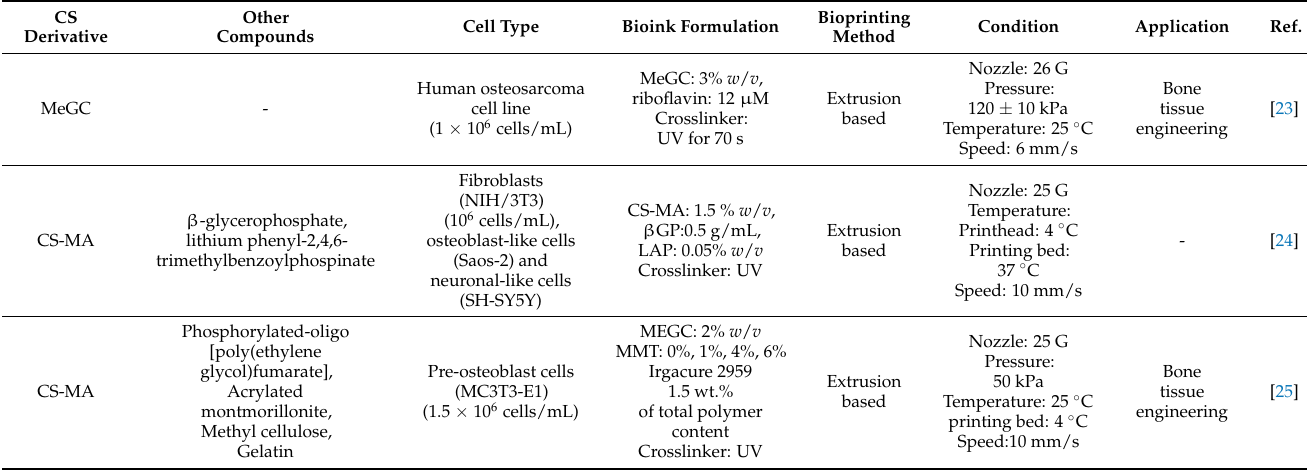
Table 3. Summary of the recent studies on chitosan derivatives-based